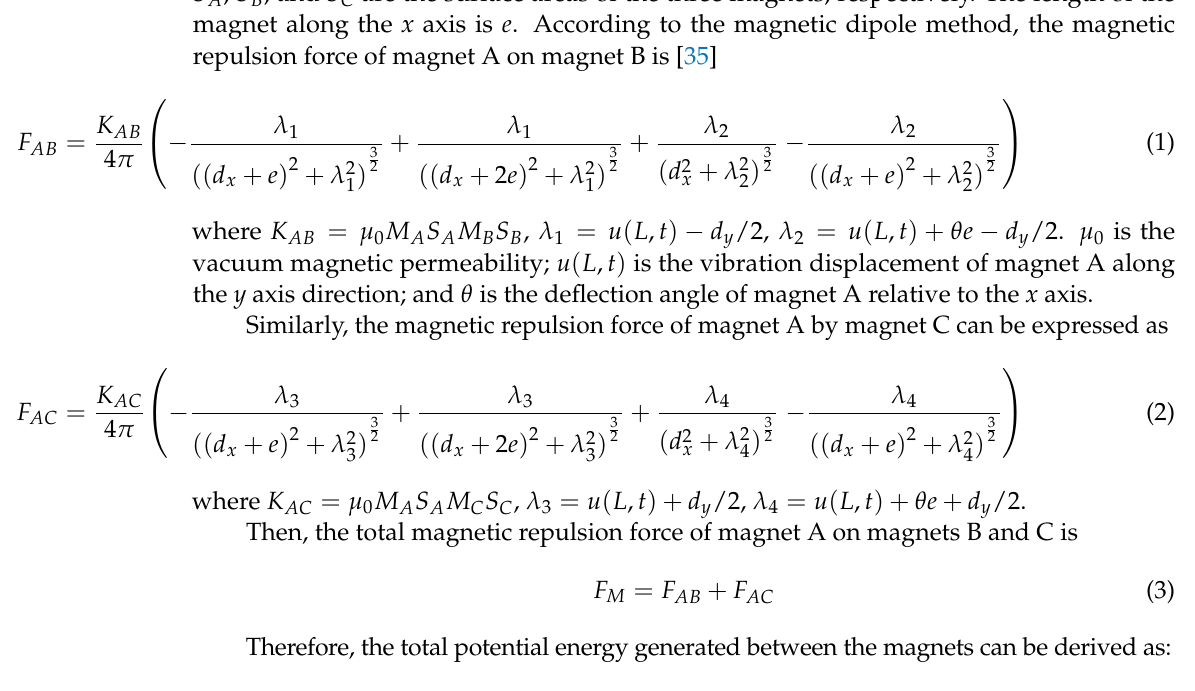
Figure 2. Schematic diagram of magnet position relationship.